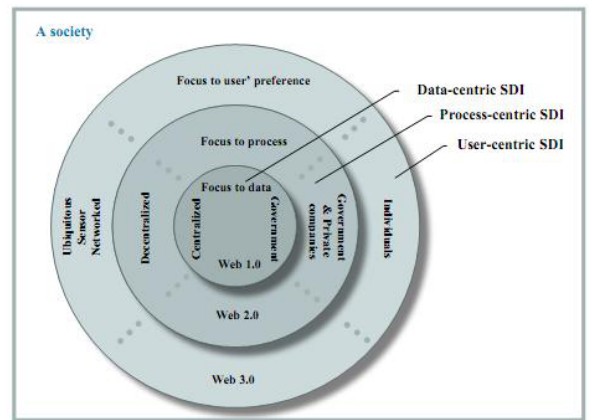
Figure 2. User-centric view acts as a key element of 3 rd generation of SDI (Sadeghi-Niaraki et al.